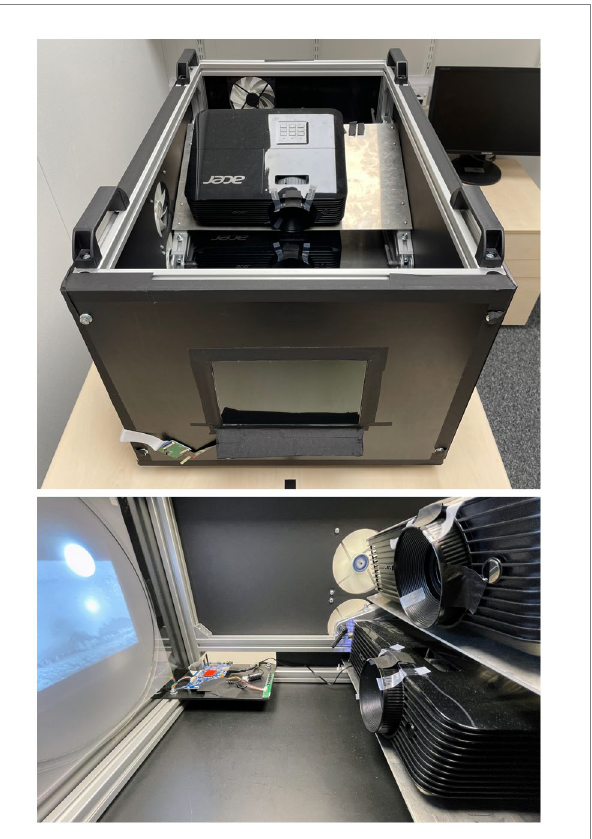
FIGURE 5 MPHDR display system used in this experiment (top) system with the cover removed (bottom) interior showing control electronics and the two projectors, of which only the lower one was used for this